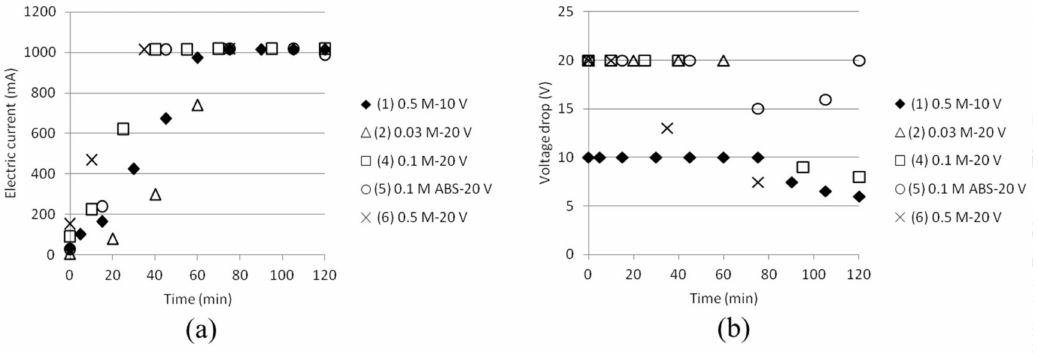
Figure 7. ( a ) Electric current as function of time as a total over the stack, (cross section area 77 cm 2 ); ( b ) Voltage drop as function of time.